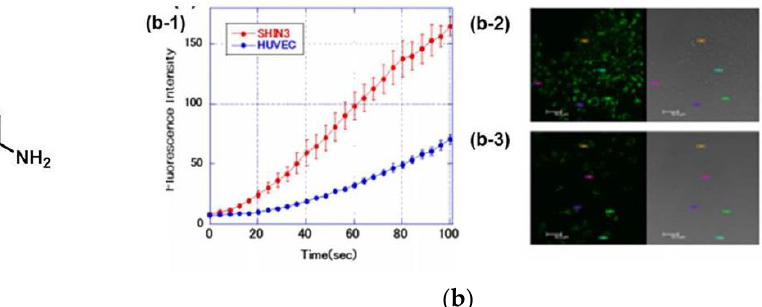
Figure 18. ( a ) Structure of probe DNs-HMRG; ( b ) ( b-1 ) Time course of fluorescence intensity of SHIN3 cells and HUVEC cells after adding DNs-HMRG; ( b-2 ) Confocal images of SHIN3 cells and ( b-3 ) HUVEC cells after adding DNs-HMRG. Reproduced with permission from [82]. Copyright 2014 Elsevier Ltd.